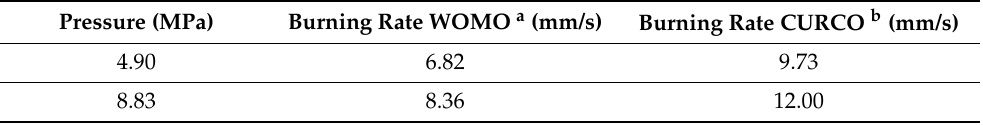
Table 5. Comparison between burning rates of propellant samples